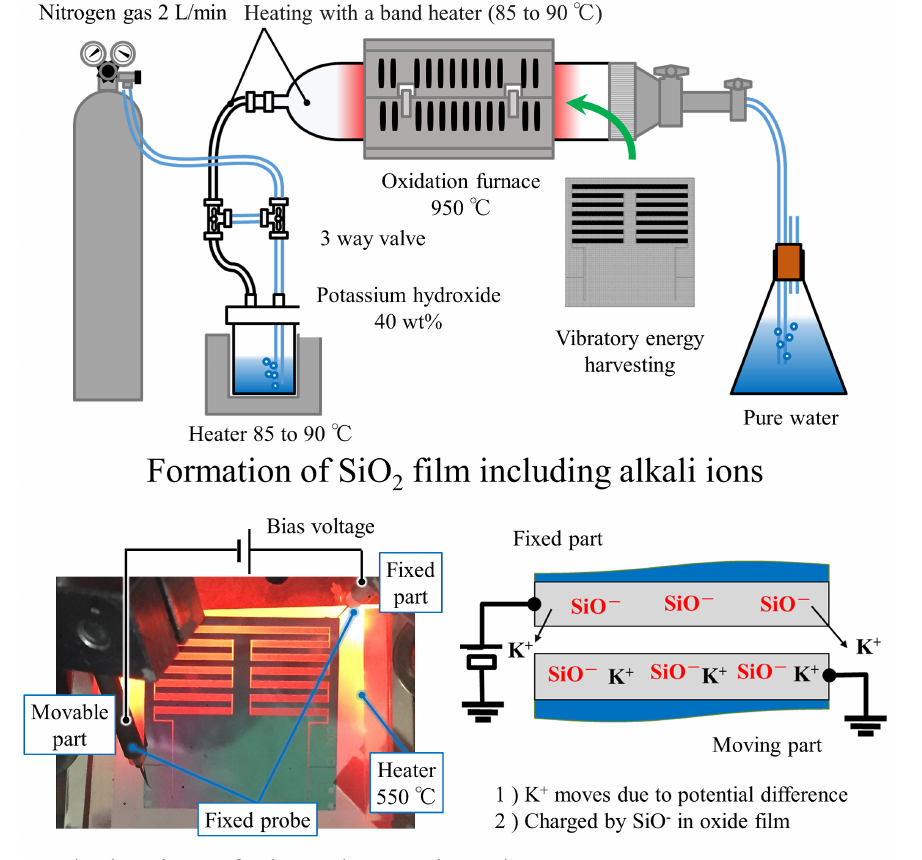
Figure 3. Formation of SiO 2